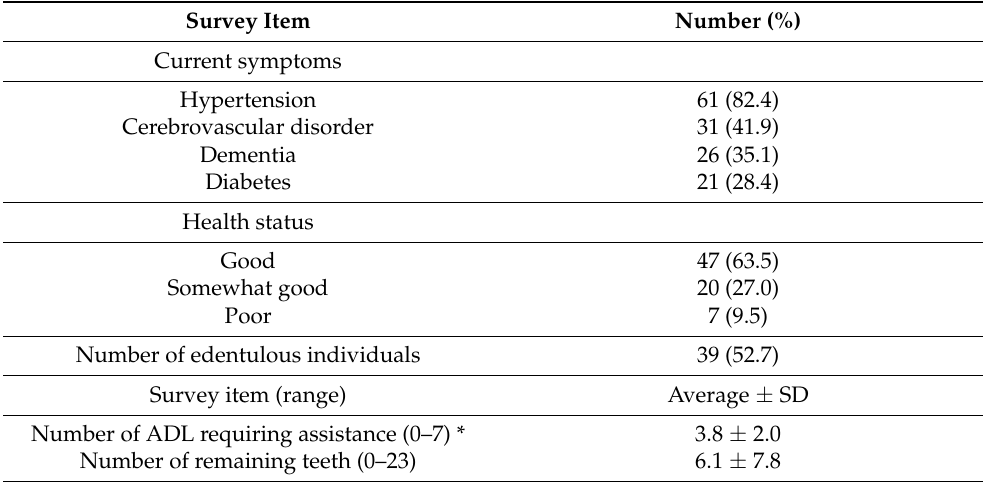
Table 3. General and oral condition.